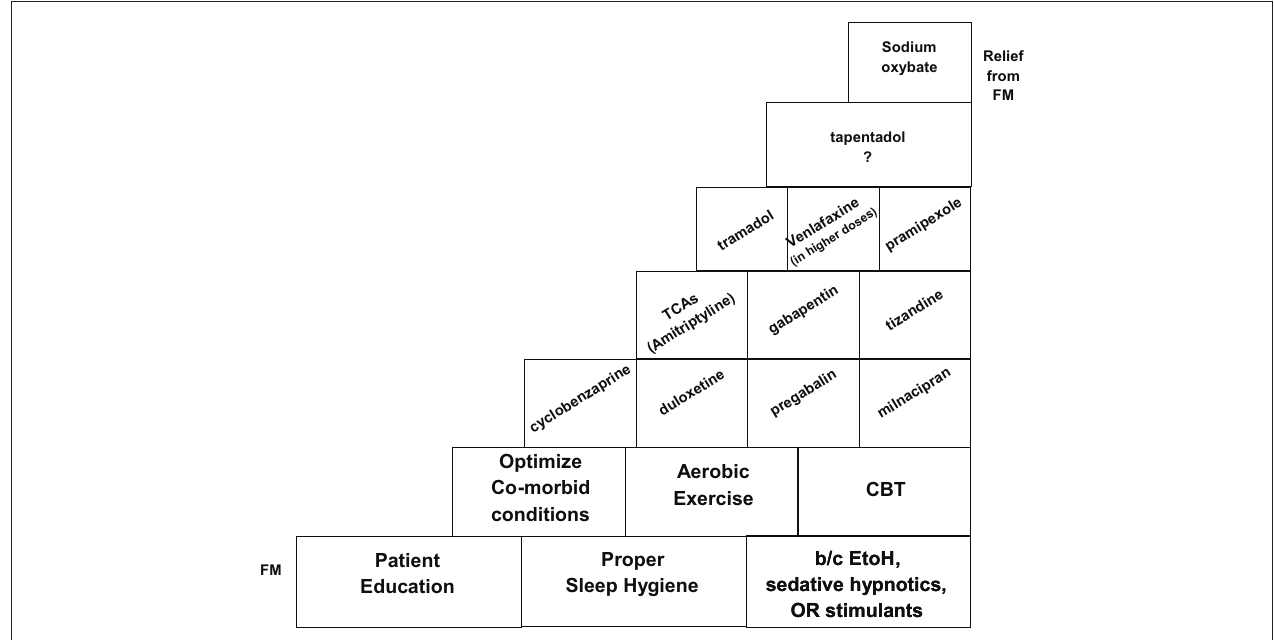
Figure 4 | Clinical algorithm for the management of